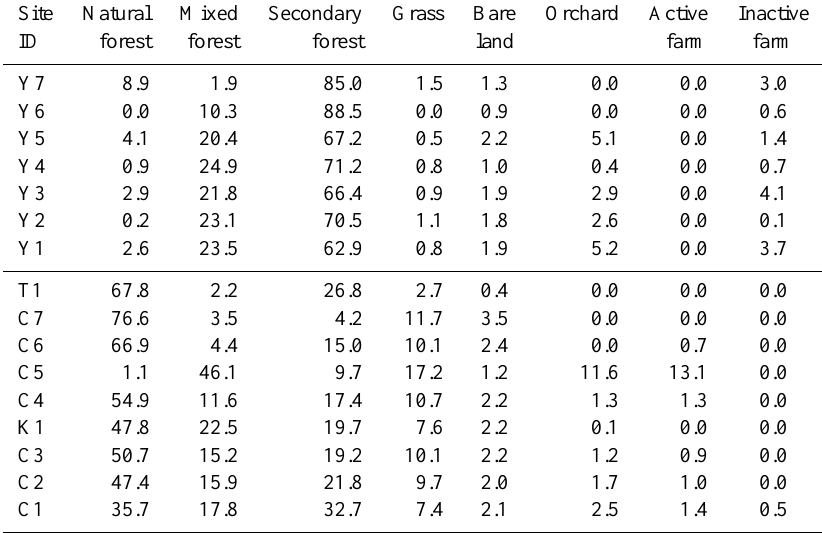
Table 2. The land use composition (%) within the 16 sampling sites. Site Natural Mixed Secondary Grass Bare Orchard Active Inactive forest forest forest